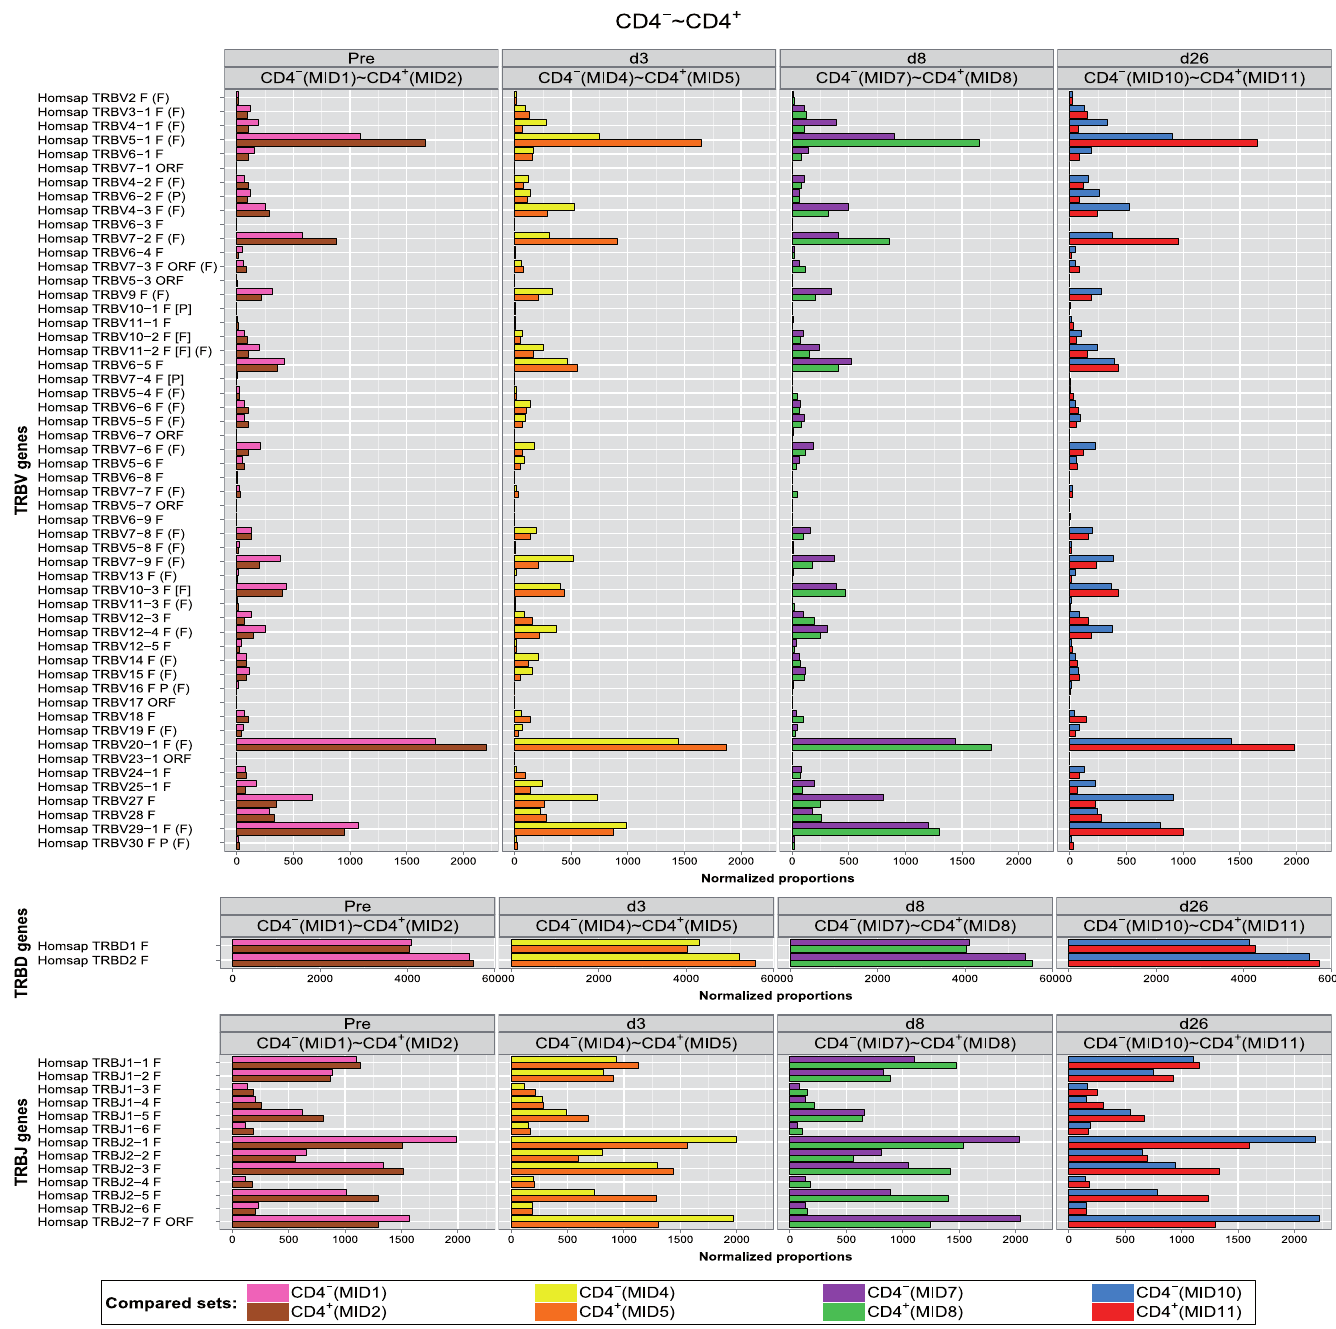
Fig 1. Normalized bar graphs of the proportions. The normalized bar graphs of the proportions for Homo sapiens TRB IMGT clonotypes (AA) with a gene of a given group (TRBV, TRBD or TRBJ) are shown between two T cell populations (CD4 - and CD4 + ) at four time points (Pre, d3, d8 and d26). IMGT clonotypes (AA) proportions are normalized for 10,000 IMGT clonotypes (AA) per group. Juxtaposed colored bars in each panel correspond to CD4 - (top) and CD4 + (bottom).